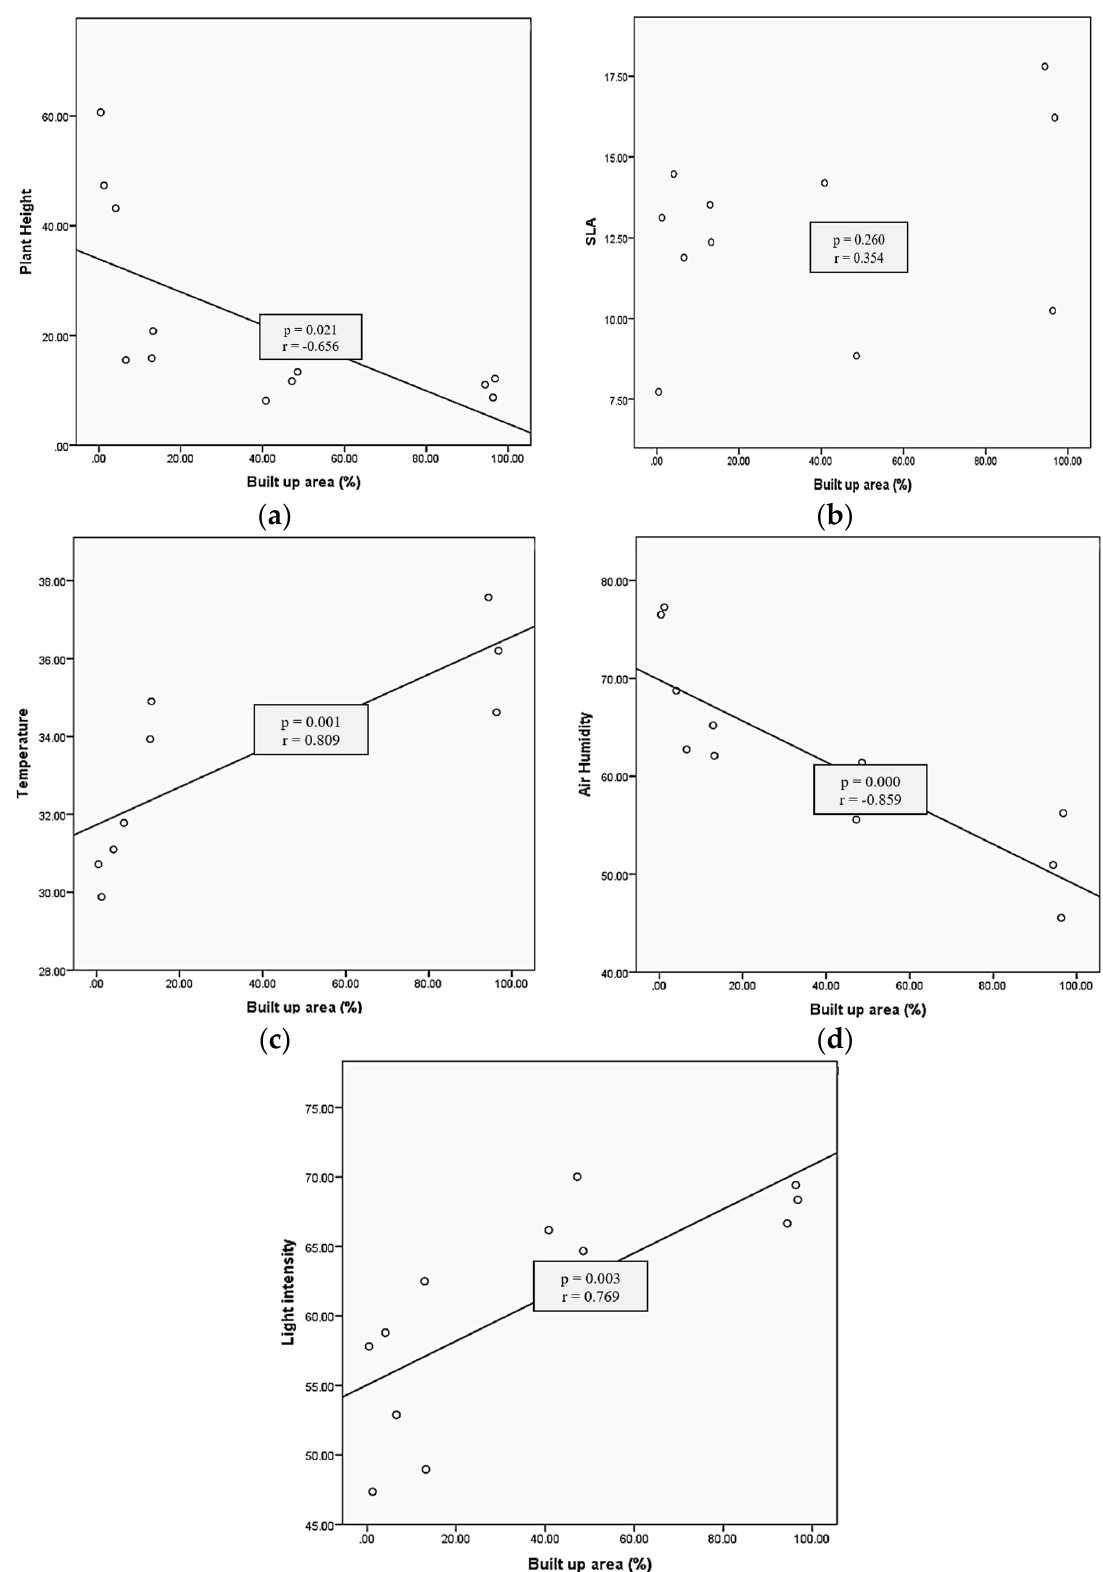
Figure 3. Relationship between percentage of built-up area and ( a ) plant height (m); ( b ) SLA; ( c ) temperature (°C); ( d ) air humidity (%); and ( e ) light intensity (Klux).